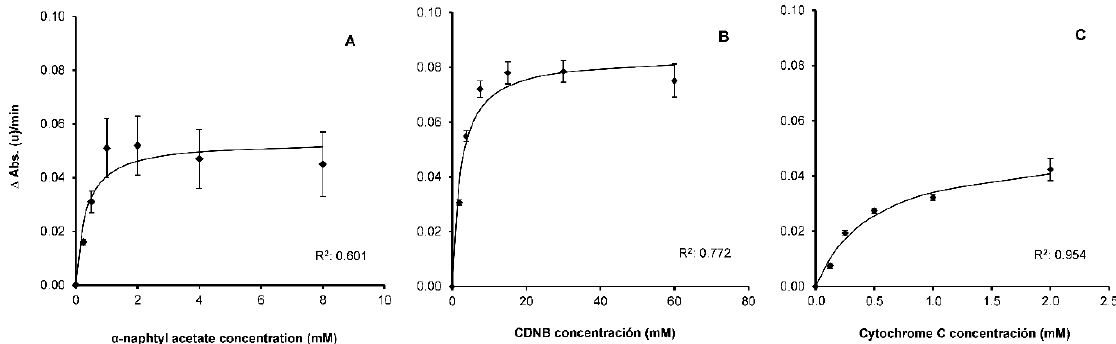
Figure 2. Substrate concentration ( α -naphthyl acetate ( A ), 1-chloro-2,4-dinitrobenzene (CDNB) ( B ) and cytochrome C ( C )) influence the reaction rate ( ∆ Abs.(u)/min). The continuous line in the figures indicates a theoretical hyperbolic curve obtained by fitting the Michaelis–Menten equation to the data. The error bars correspond to standard error (total number of insects tested, A: n = 28, B: n = 56, C: n = 12).